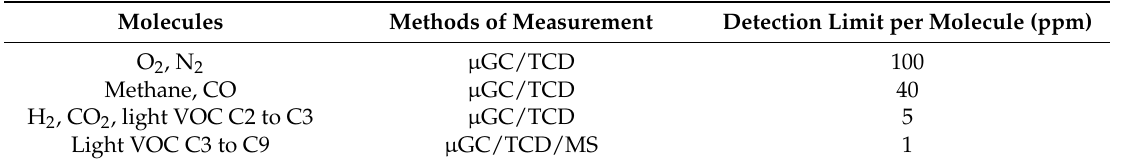
Figure 6. Example of a kinetic curve of ethylbenzene and benzene emissions in paste C.